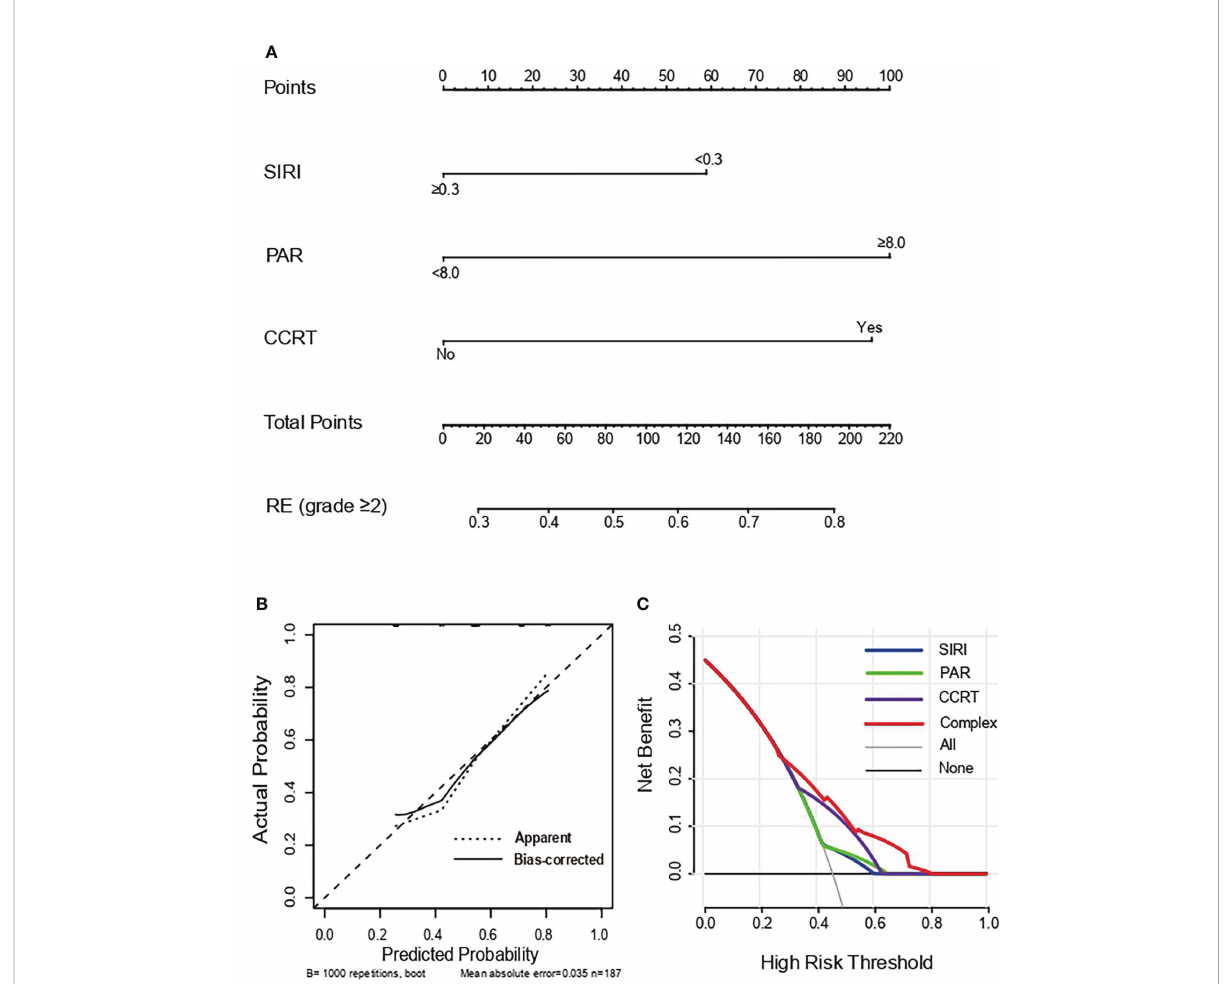
FIGURE 2 Nomogram, Calibration curve and Decision curve predicting the development of grade ≥ 2 RE. (A) A nomogram incorporated SIRI, PAR and CCRT in SCLC patients. (B) Calibration curves of the occurrence of grade ≥ 2 RE for SCLC patients in the nomogram. The X-axis and Y-axis represent the predicted probability and actual probability respectively. The 45° dotted line showed the best predicted value. (C) Decision curves of the occurrence of grade ≥ 2 RE for SCLC patients in the nomogram. The X-axis and Y-axis represent the threshold probabilities and the net bene fi t respectively which is computed by adding the true positives and subtracting the false positives. The green, blue, purple and red lines display the net bene fi t of the SIRI, PAR, CCRT and Complex, respectively. RE, radiation esophagitis; SIRI, system in fl ammation response index; PAR, platelets-albumin ratio; CCRT, concurrent